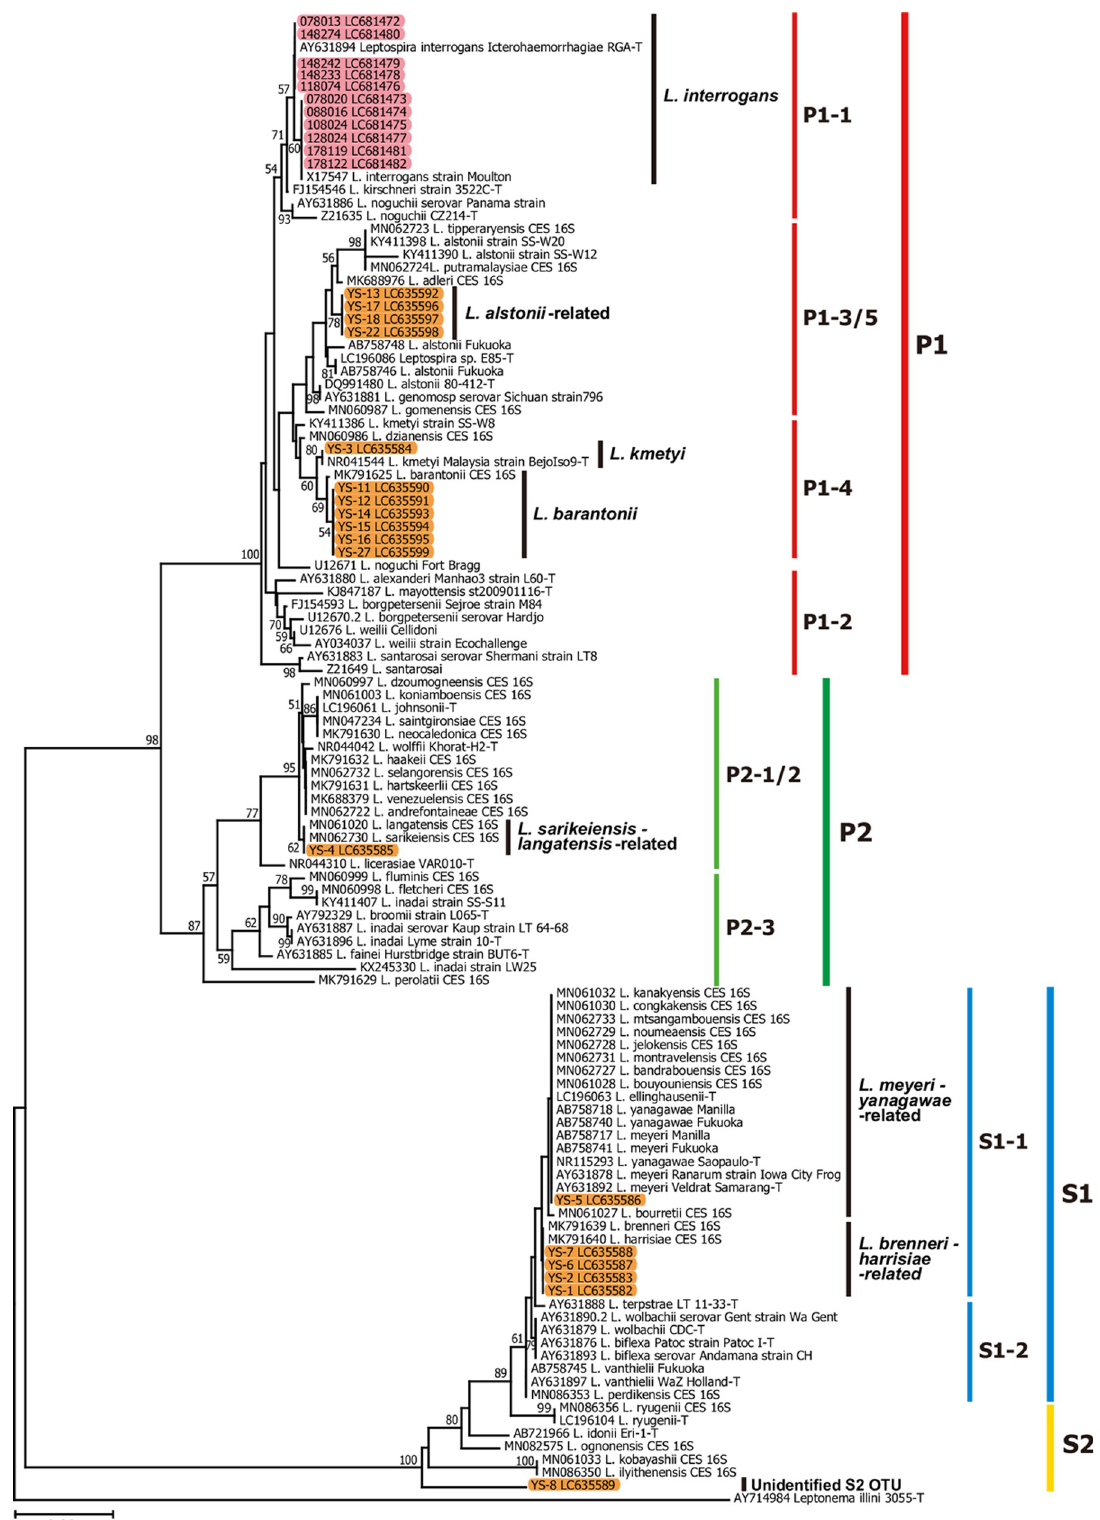
Fig 2. Molecular phylogenetic tree of leptospiral 16S rRNA sequences from human and soil isolates with those of representative Leptospira species. Red and orange shading indicate the 16S rRNA genes determined from Leptospira cultures from human patients